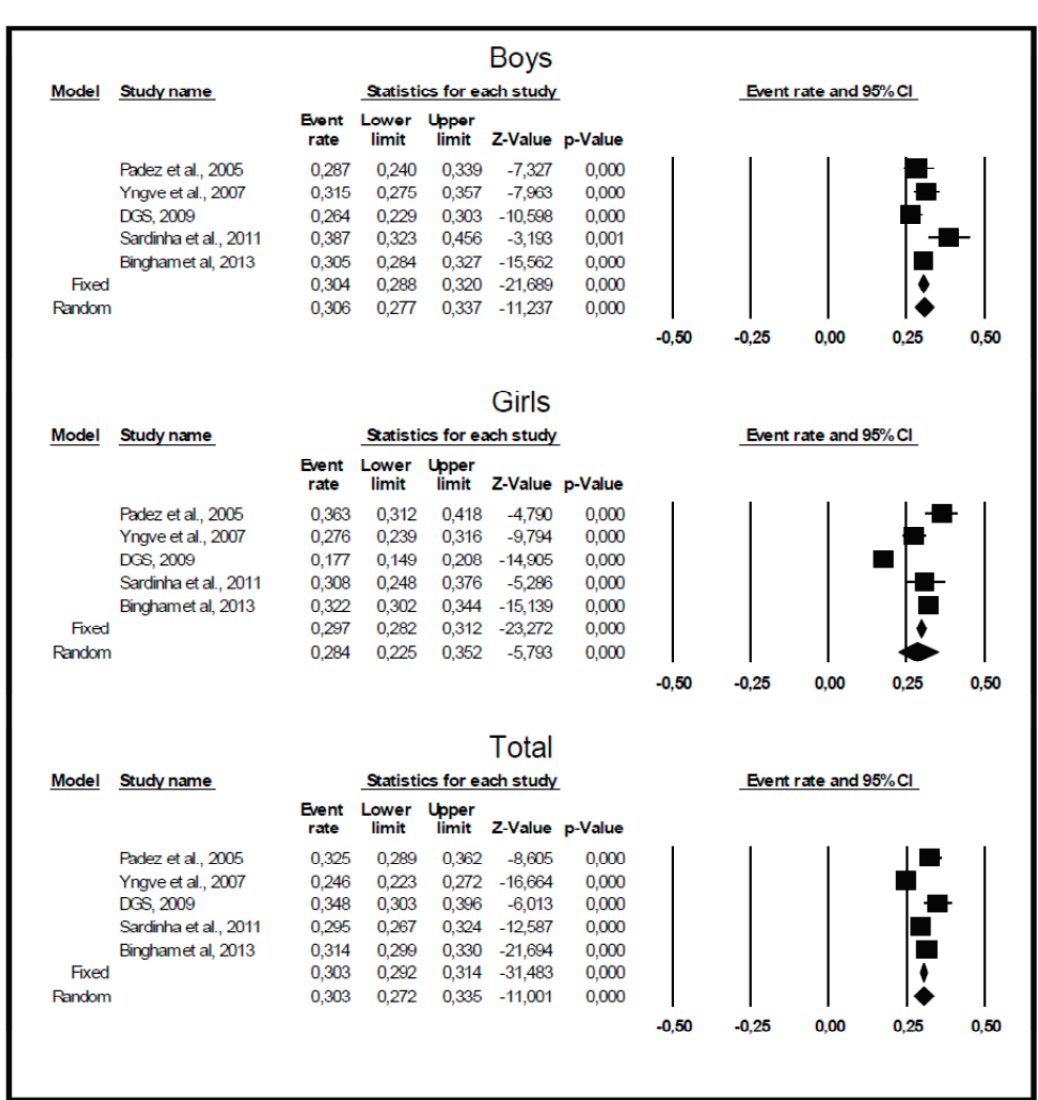
Figure 2. Meta-analysis results for boys, girls and both sexes